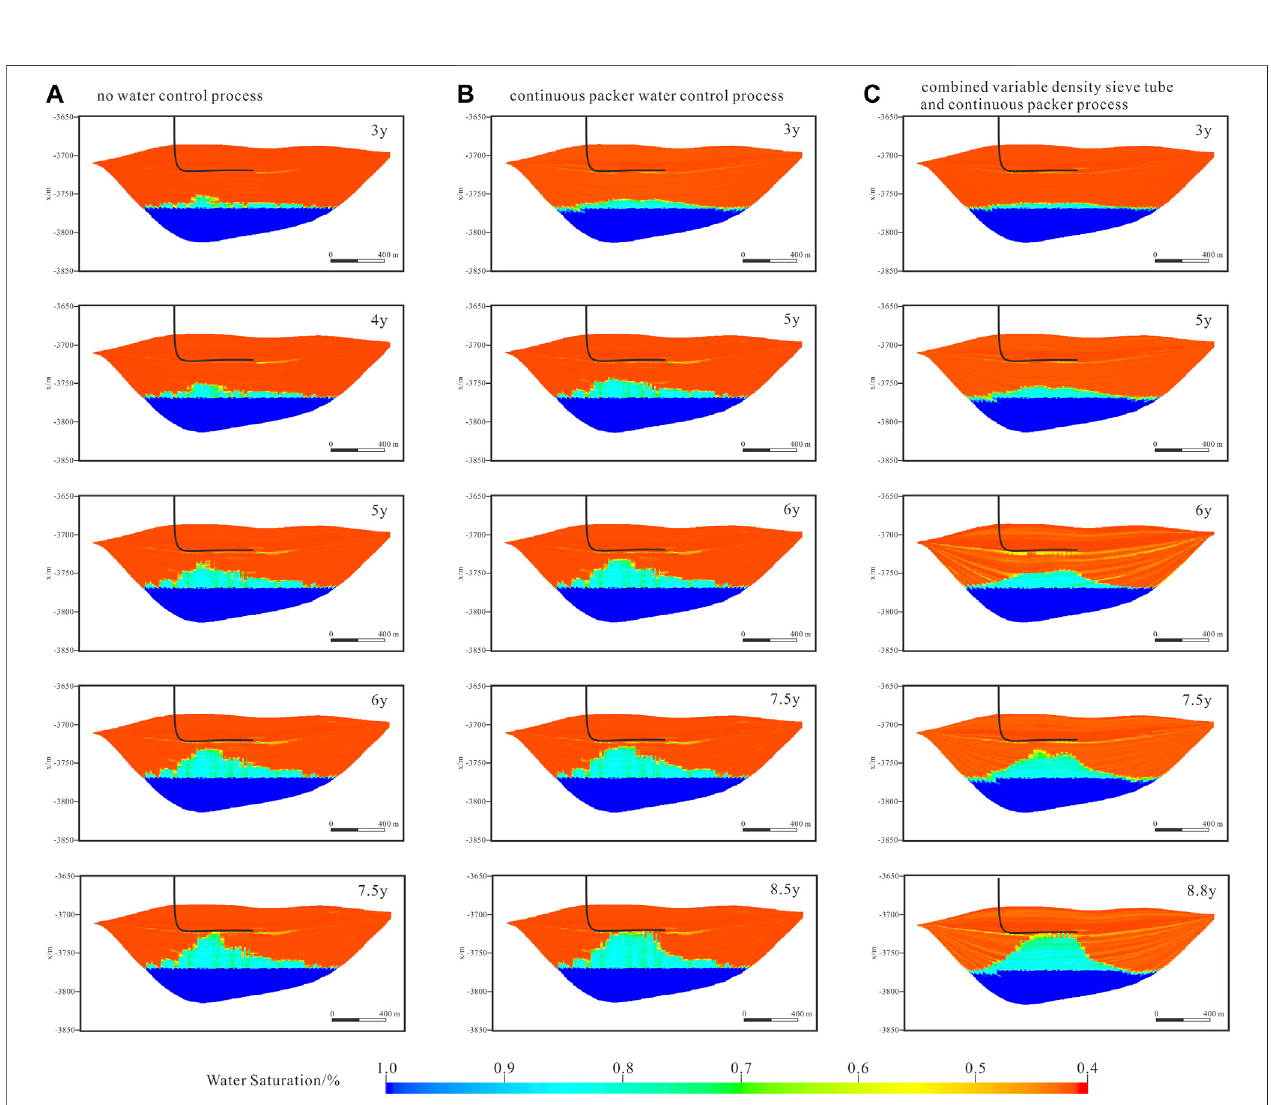
FIGURE6| DiagramofthewaterintrusionprocessinwellH1fordifferentwatercontrolmodels. (A) Nowatercontrolprocess. (B) Continuouspackerwatercontrol process. (C) Combined variable density sieve tube and continuous packer process.